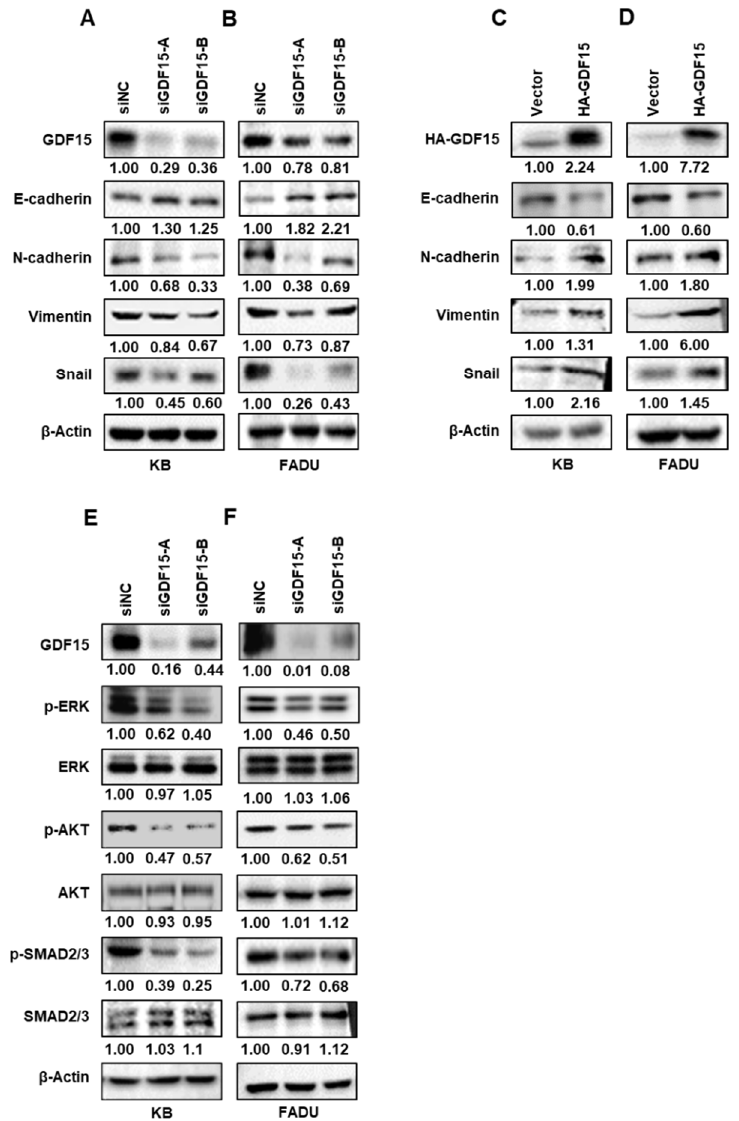
Figure 3. GDF15 promotes EMT-related proteins through SMAD, ERK and AKT signaling pathways in HNC. ( A – D ) KB and FADU cells were transiently transfected with GDF15 siRNAs or negative control siRNA for 48 h and HA-GDF15 vector or negative control vector for 24 h. After transfection, the levels of the EMT-related proteins E-cadherin, N-cadherin, vimentin, and Snail were evaluated by Western blots. ( E , F ) Representative images of Western blot analysis showing the expression of p-ERK, ERK, p-AKT, AKT, p-SAMD2/3 and SMAD2/3 followed by knockdown of GDF15 in KB and FADU cells. Each figure is representative of three independent experiments.